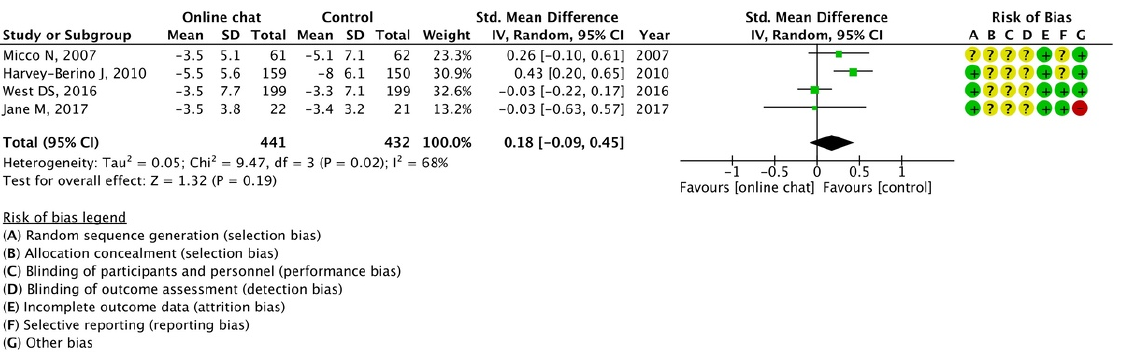
Figure 6. Meta-analysis for mean weight change with or without e-counseling using 4 articles [14,19,43,57]. The forest plot shows standardized mean differences (SMD) for each article with 95% confidence intervals (CI). The diamond at the bottom of the graph means the meta-analyzed measure of effect and the lateral points of which indicate CIs for this estimate. A positive value reflects web-based interventions with e-counseling are more effective for weight loss than web-based interventions without e-counseling. The area of each green square is proportional to the study's weight in the meta-analysis.